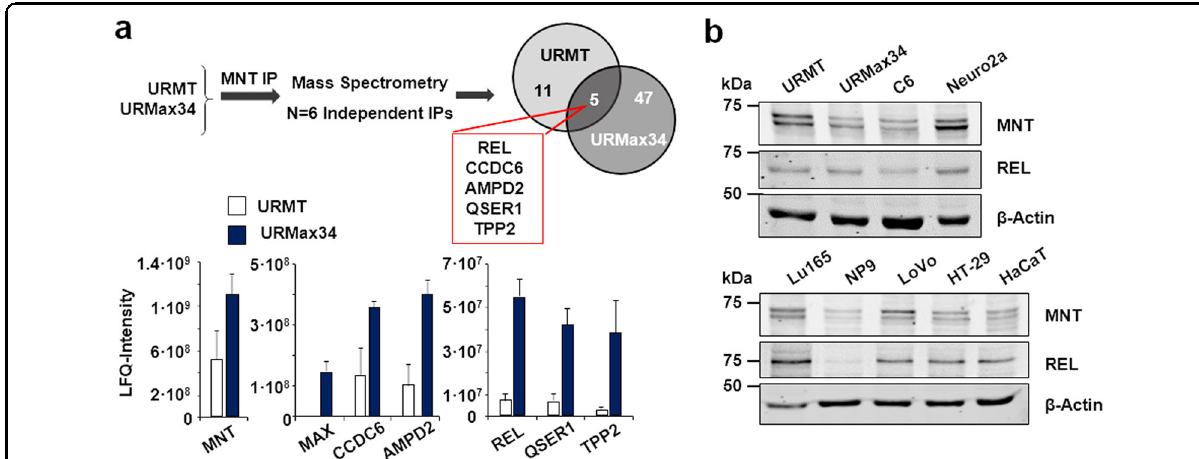
Fig. 1 Proteins interacting with MNT. a Top : Schematic representation of the proteomic study: URMT and URMax34 cells were treated with 100µM Zn 2 SO 4 for 24h and lysed for posterior MNT immunoprecipitation. Six independent immunoprecipitations were analyzed by mass spectrophotometry and fi ve proteins were found bound to MNT in URMT and URMax34. Bottom: Quanti fi cation of the protein interactions. The bar graphs represent mean LFQ intensity values of the selected MNT interactions± S.D. ( n = 6). P < 0.05 with respect to IgG. b Immunoblot of MNT and REL in different cell lines: URMT (control UR61) and URMax34 (UR61 with MAX expression induced by Zn 2 + ); C6 (rat brain glioma); Neuro-2a (mouse neuroblastoma); Lu165 (small cell lung cancer); NP9 (human pancreatic adenocarcinoma); LoVo and HT-29 (human colorectal adenocarcinoma); HaCaT (human keratinocyte). β -actin levels were determined as a protein loading